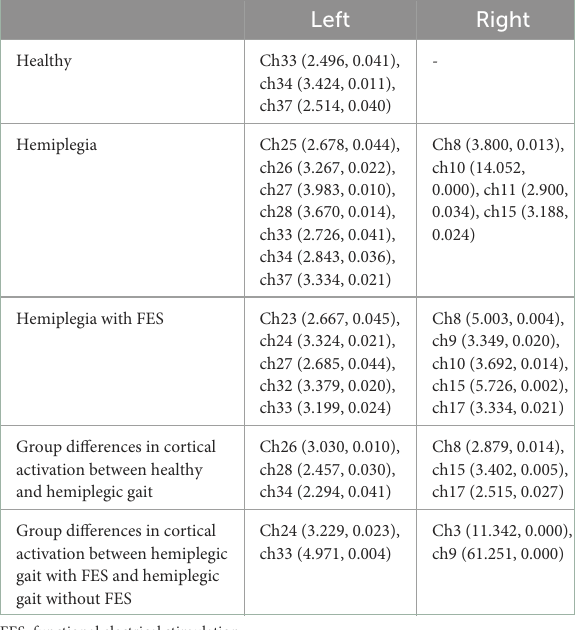
TABLE 3 List of group-level channel activation in the task (t-value, p < 0.05).